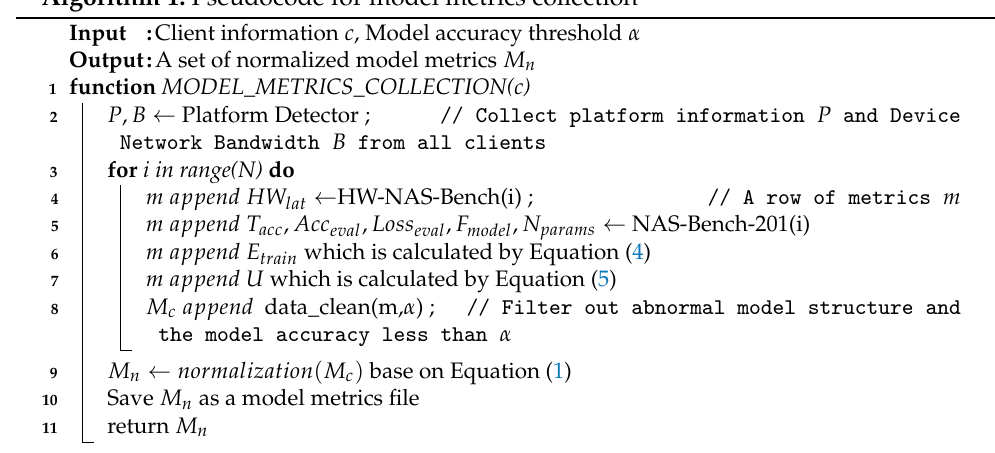
Algorithm 1: Pseudocode for model metrics collection